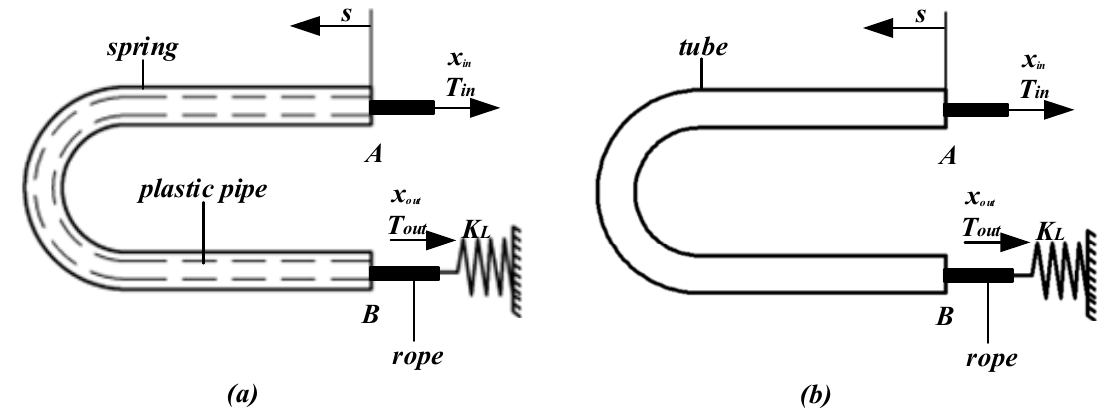
Figure 4. ( a ) Spatial arbitrary rope model diagram; ( b ) Simplified model of lasso system. The rope elements are so small that each segment is a plane curve, as shown in Figure 5, and the mass is negligible. The twist angle around the axis of the rope between the